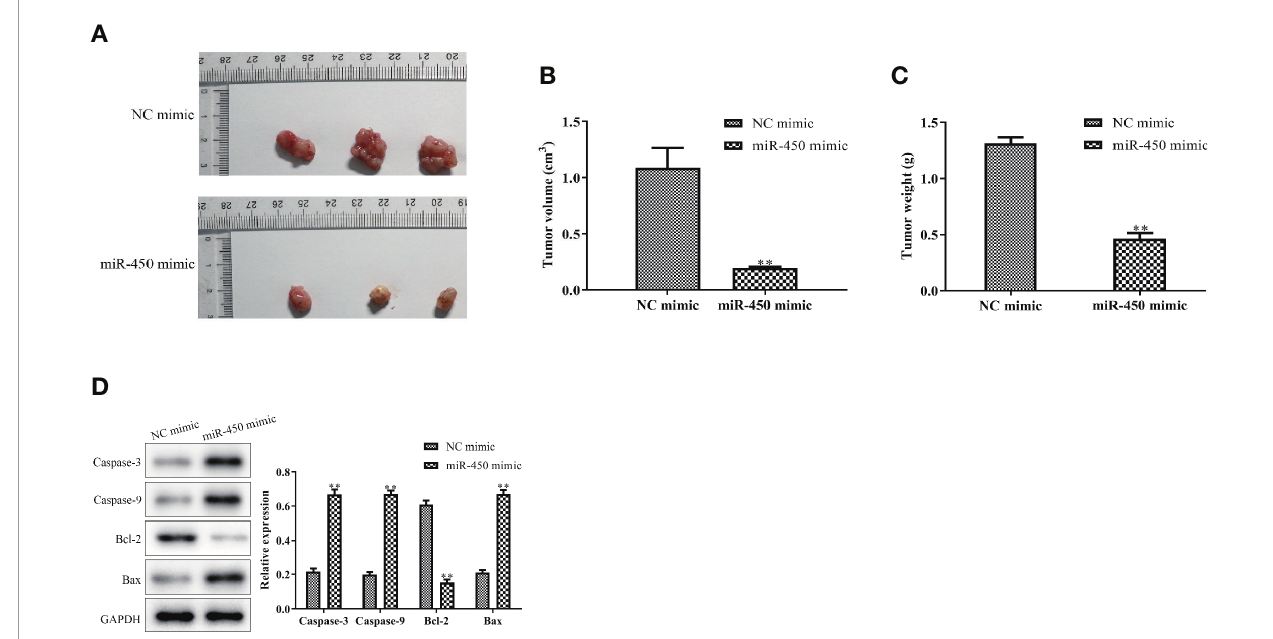
FIGURE 2 | Overexpression of miR-450a-5p inhibits tumor growth. (A – C) Tumor phenotype, tumor volume, and weight. (D) Western blot analysis on the expression of apoptosis-associated proteins in tumor tissues. ** P <0.01 vs. miR-NC